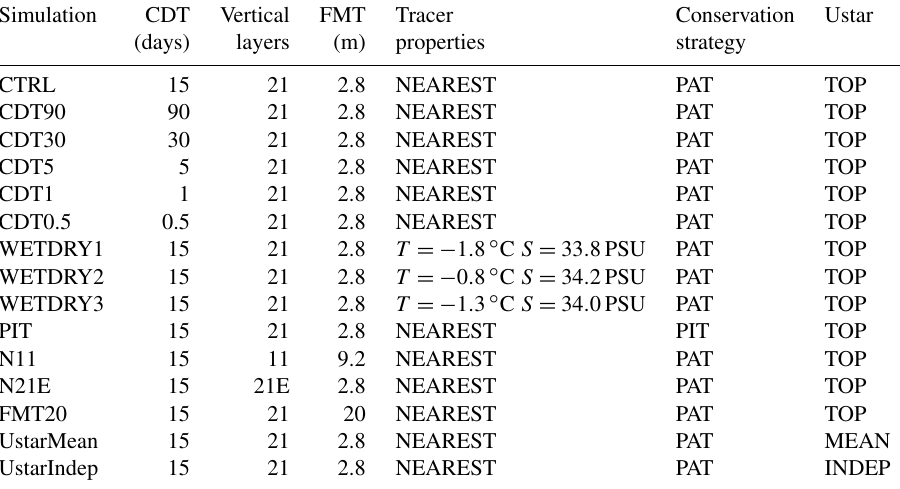
Table 1. Summary of the experiments used in this study. NEAREST means the tracer properties of the dry cells are set to be equal to the nearest wet cell. 21E means 21 vertical layers with equal layer thickness. CDT means the coupling interval. FMT means the flux mixing thickness representing the depth over which meltwater fluxes are mixed or distributed. FMT is set to 20m in FMT20, while in other experiments, it equals the spatially averaged top layer thickness. PIT means the volume integral of tracer properties are preserved, while PAT means the absolute tracer properties are preserved. TOP means the friction velocity is calculated based on the velocity of the top model cell. MEAN means the friction velocity is calculated from the mean velocity of the top three model cells. INDEP assumes that the tracer property transfer is independent from the friction